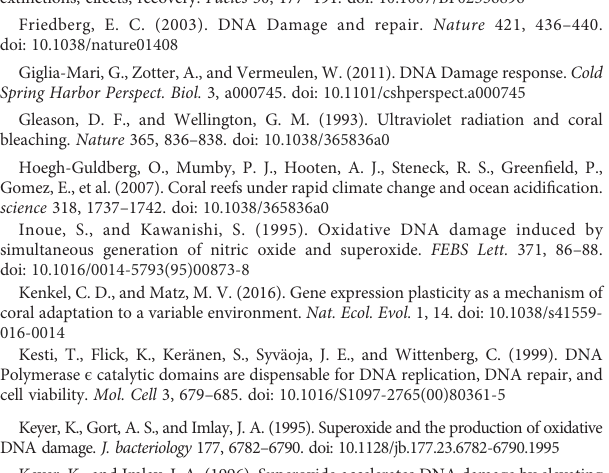
SUPPLEMENTARY TABLE 3 The results of the PSGs of stony coral ancestors.